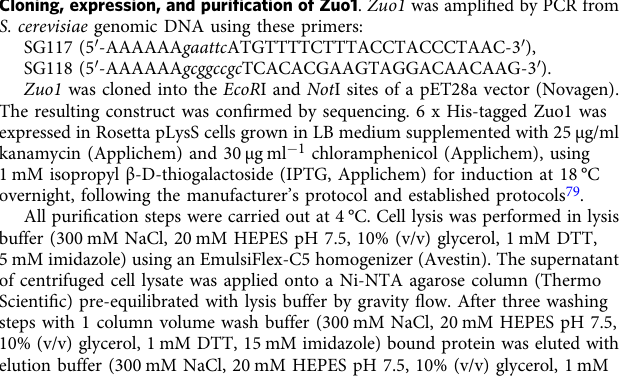
screening bait G4 strain. The control bait G4 mut was cloned using the same strategy. After determination of the minimal inhibitory concentration of Aur- eobasidin A (AbA), screens were performed using the S. cerevisiae DUALhybrid cDNA library (Dualsystems Biotech). 7µg cDNA library plasmid were transformed into the screening strain bait-G4 according to the manufacturer ’ s protocol. After streaking out each yeast colony twice on selective plates the library plasmids were isolated from overnight cultures. Lysis was performed using DNA lysis buffer (2% (v/v) Triton X-100, 1% (w/v) SDS, 100 mM NaCl, 10mM Tris HCl pH 8.0, 1mM EDTA) and glass beads in a FastPrep instrument (MP Biomedicals ™ FastPrep-24 ™ ) for 1 min at 4°C, followed by phenol-chloroform extraction and ethanol pre- cipitation. Plasmids were transformed in E. coli (XL-1 Blue) and overnight cultures were used to isolate plasmids by alkaline lysis. The obtained library plasmid was sent for sequencing using the primer GAL4ADseq (sequence from Dualsystems Biotech): 5 ′ -ACCACTACAATGGATGATG-3 ′ . Cloning, expression, and puri fi cation of Zuo1 . Zuo1 was ampli fi ed by PCR from S. cerevisiae genomic DNA using these primers: SG117 (5 ′ -AAAAAA gaattc ATGTTTTCTTTACCTACCCTAAC-3 ′ ), SG118 (5 ′ -AAAAAA gcggccgc TCACACGAAGTAGGACAACAAG-3 ′ ). Zuo1 was cloned into the EcoR I and Not I sites of a pET28a vector (Novagen). The resulting construct was con fi rmed by sequencing. 6 x His-tagged Zuo1 was expressed in Rosetta pLysS cells grown in LB medium supplemented with 25 µg/ml kanamycin (Applichem) and 30µgml − 1 chloramphenicol (Applichem), using